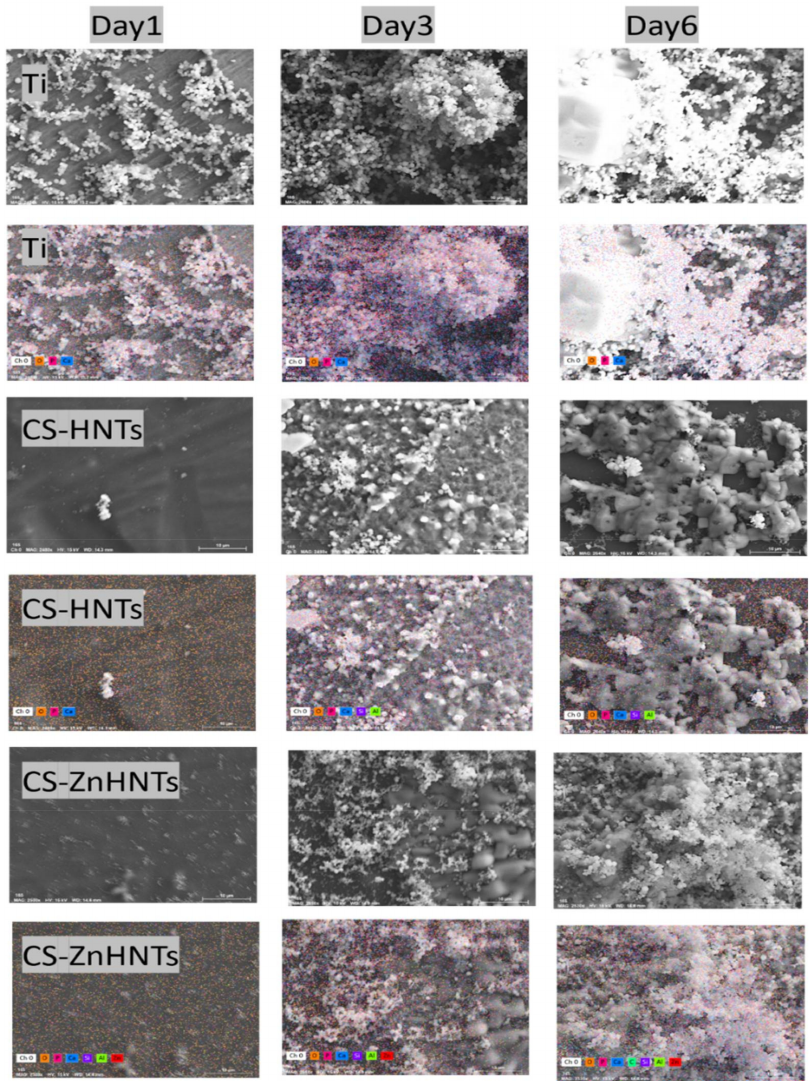
Figure 16. SEM and SEM-EDS map of the samples soaked in simulated body fluid (SBF) for 1, 3, and 6